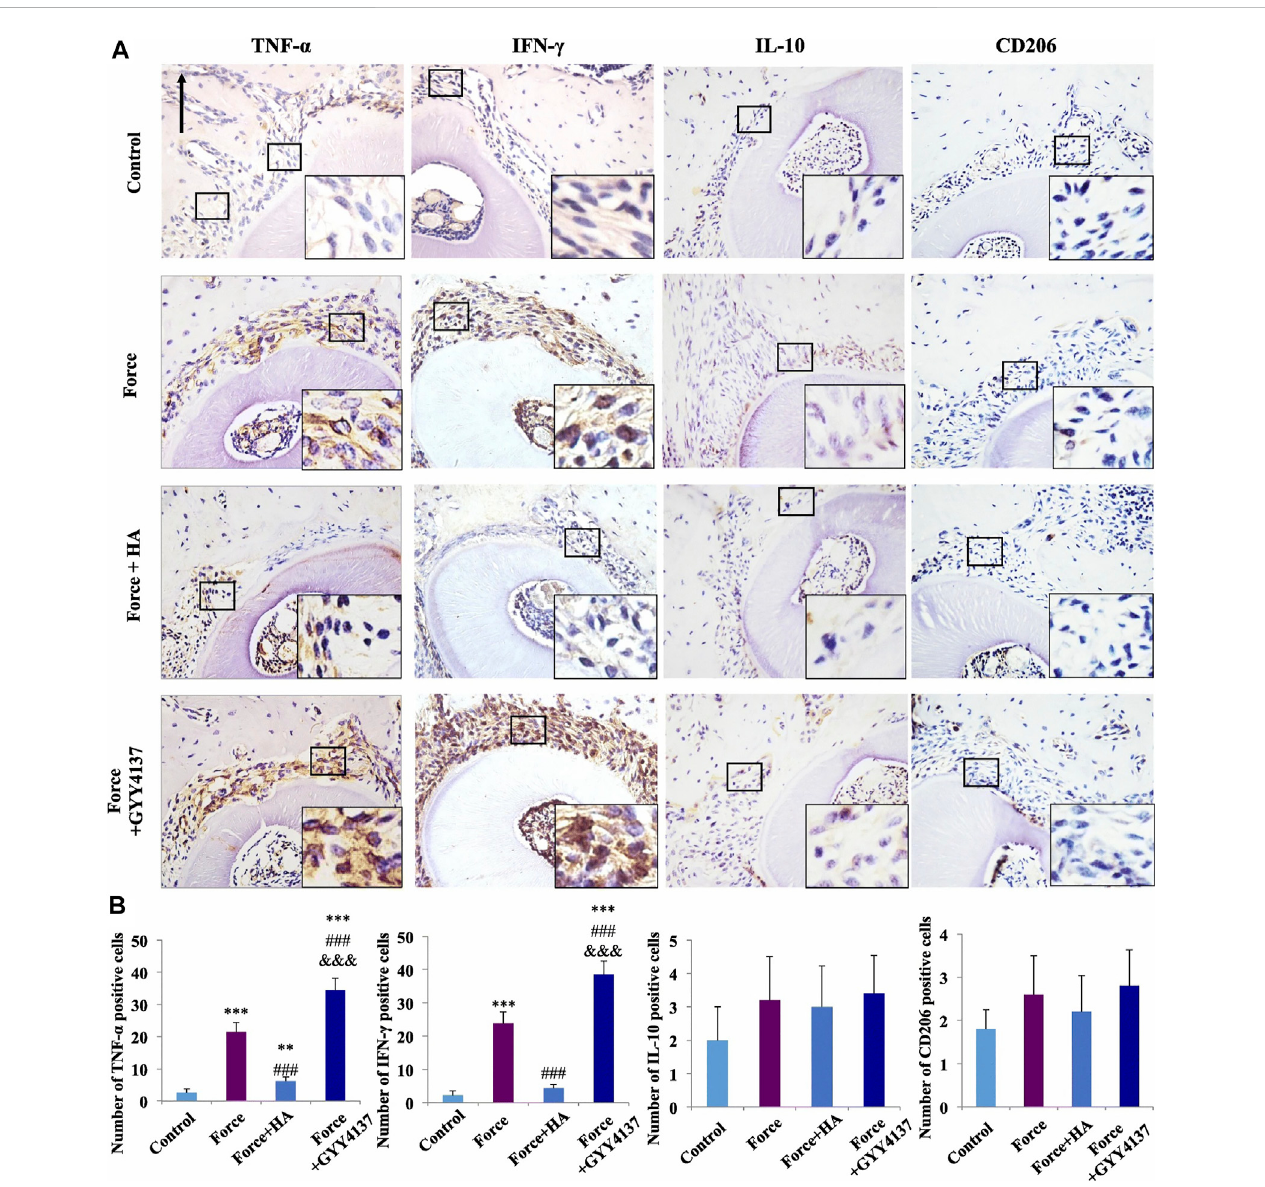
FIGURE 4 Immunohistochemical staining image of M1/M2 macrophage markers (A) . Semiquanti fi cation analysis of M1/M2 macrophage (B) . Scale bars: 100 μ m ** p < 0.01, *** p < 0.001 comapered with control. ### p < 0.001 comapered with force. and &&& p < 0.001 comapered with force + HA. Reproduced with permission from (He et al.,